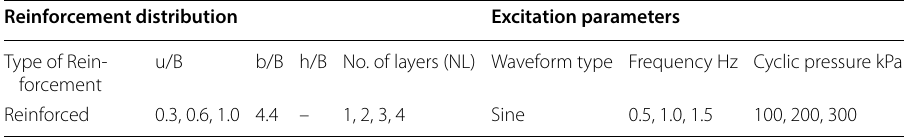
Table 3 Configuration of coir mat reinforcement